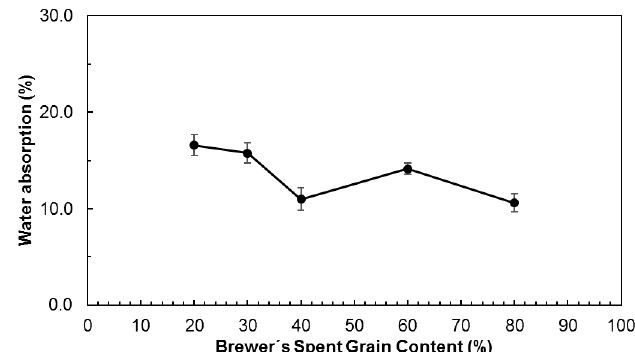
Figure 5. Water absorption, relative to the sample’s initial weight, of trays produced with different contents of Brewer´s Spent Grain.